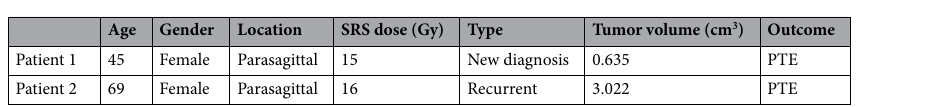
Table 6. Complications in two patients undergoing SSRS for benign meningioma. PTE peritumoral